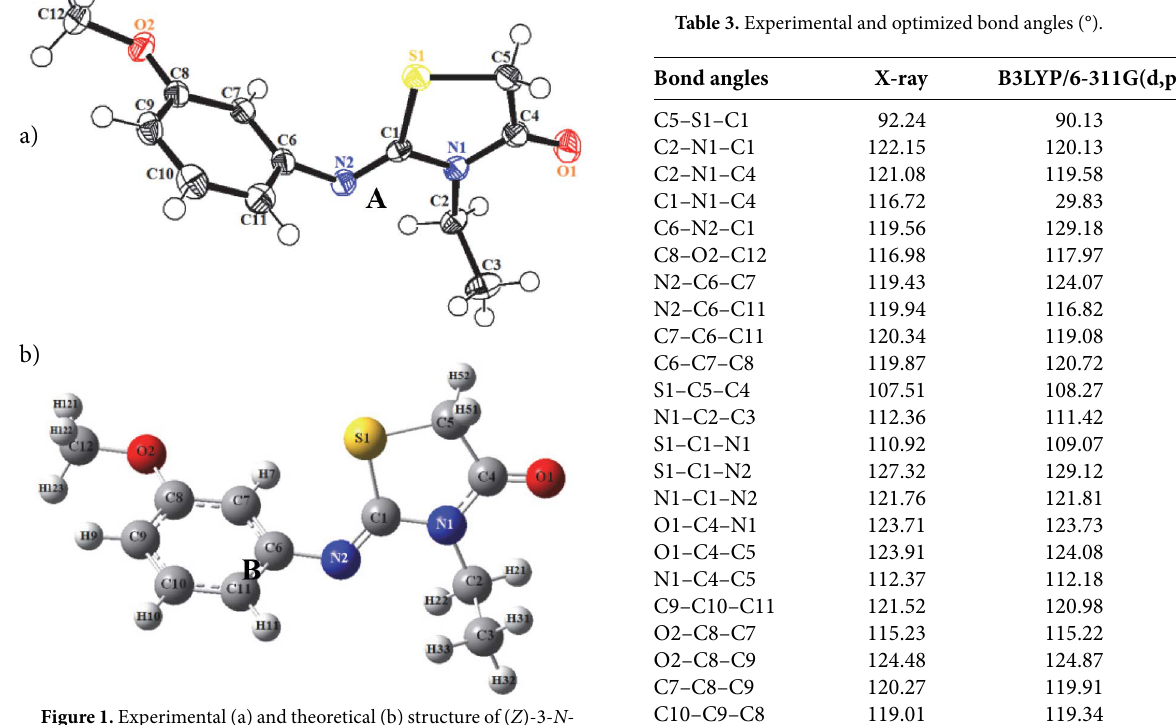
Figure 1. Experimental (a) and theoretical (b) structure of ( Z )-3- N - (ethyl)-2- N